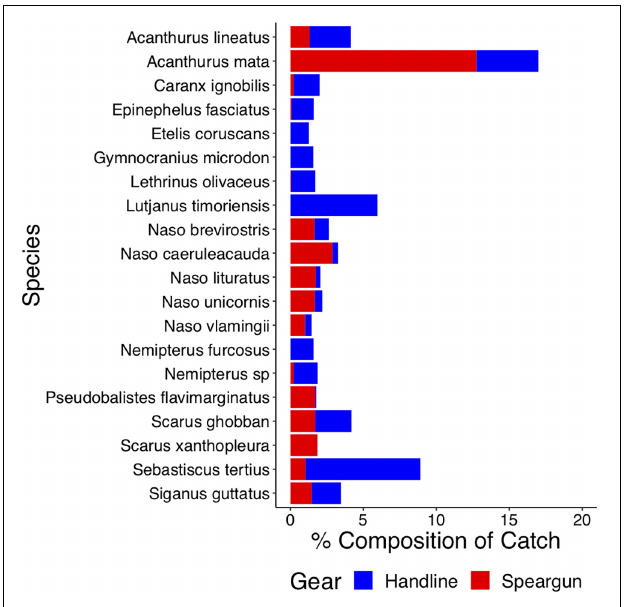
FIGURE 2 | Handline and speargun catch composition in the Lombok coral reef fishery. Species that represent greater than 2% of the total catch are presented.